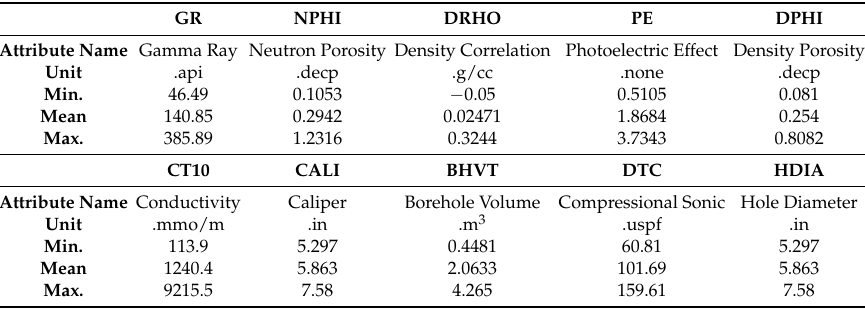
Table 1. Summaries of the selected well log